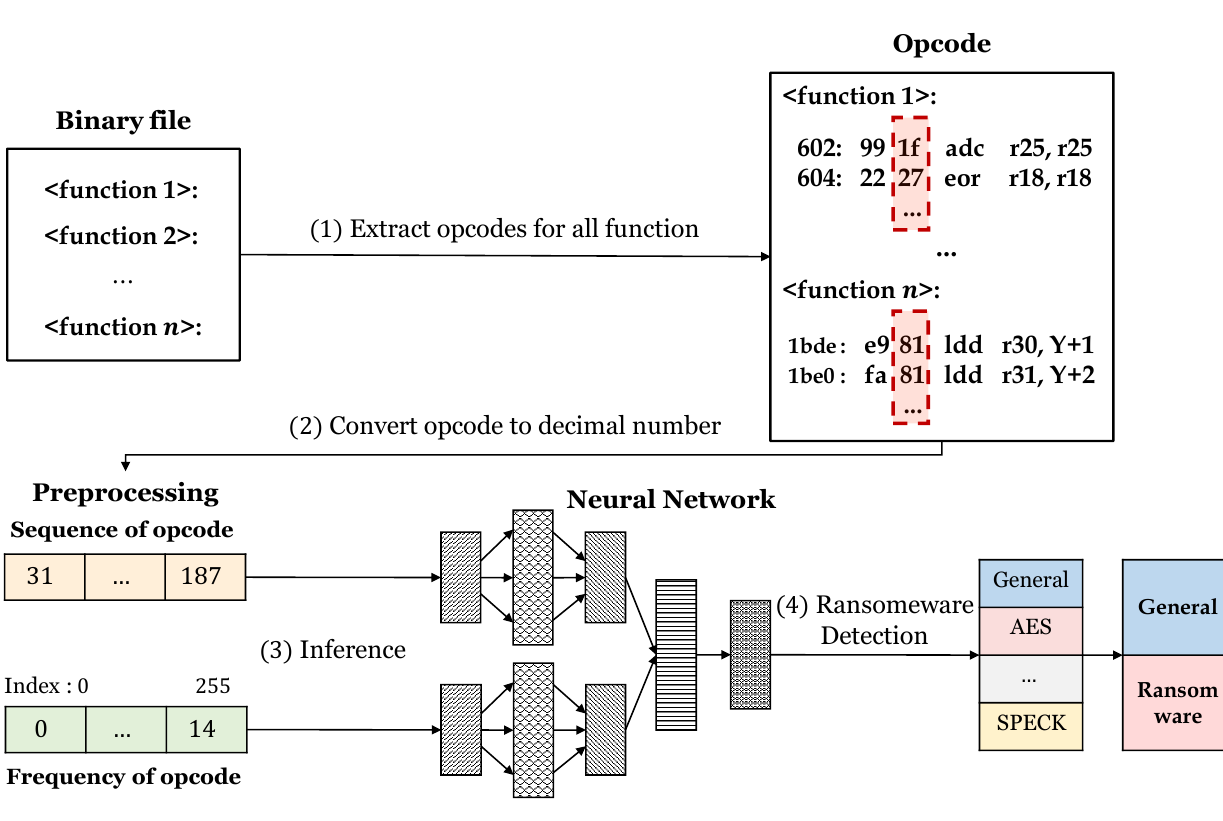
Figure 6. Ransomware detection